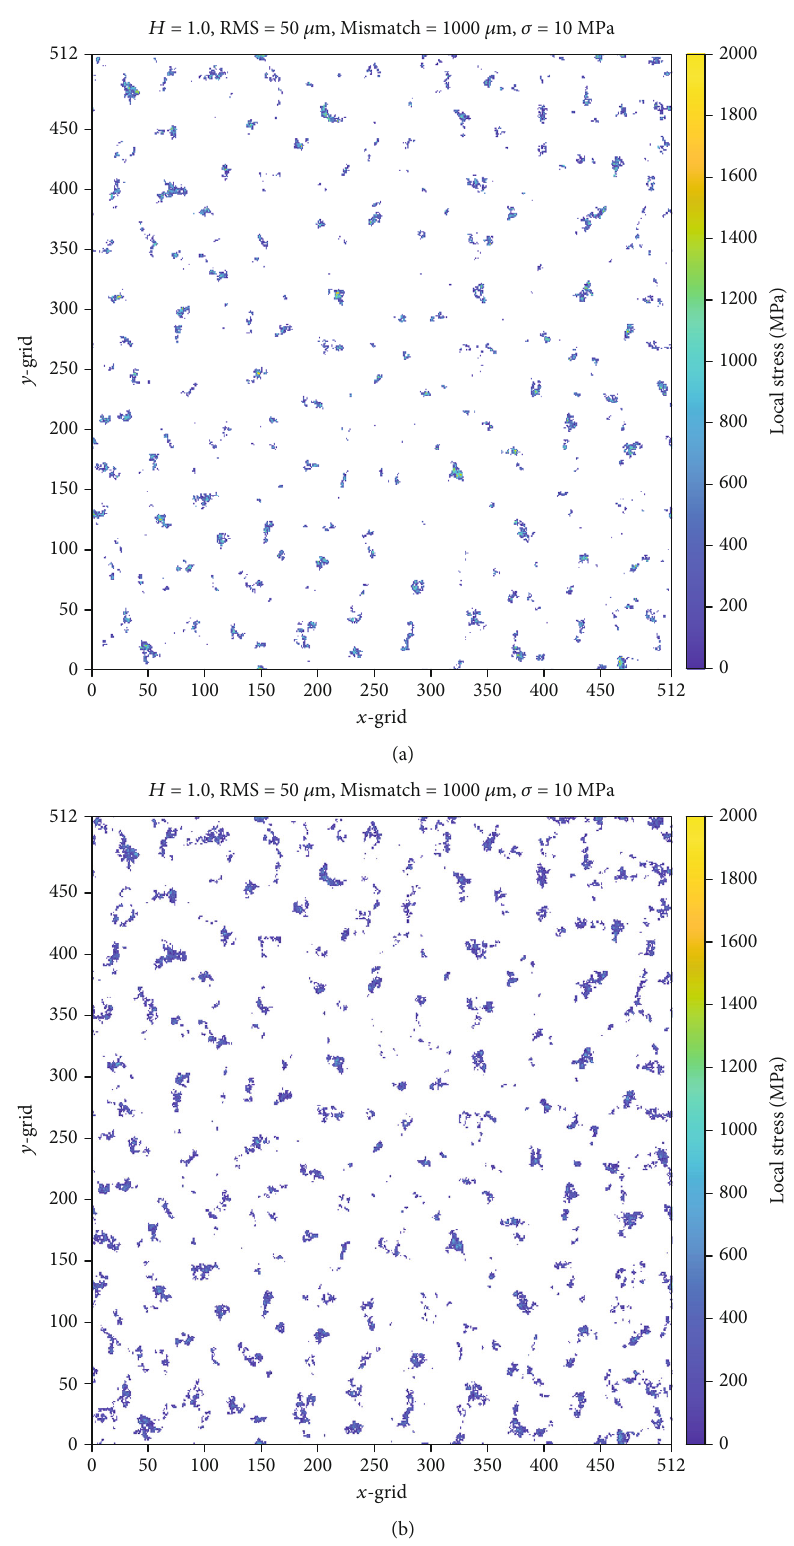
Figure 19: (a) Contact area and local contact stress before creep (the moment after the elastic deformation); (b) contact area and local contact stress after creep (the time duration is 5 τ ). The number of grids in the x and y directions is